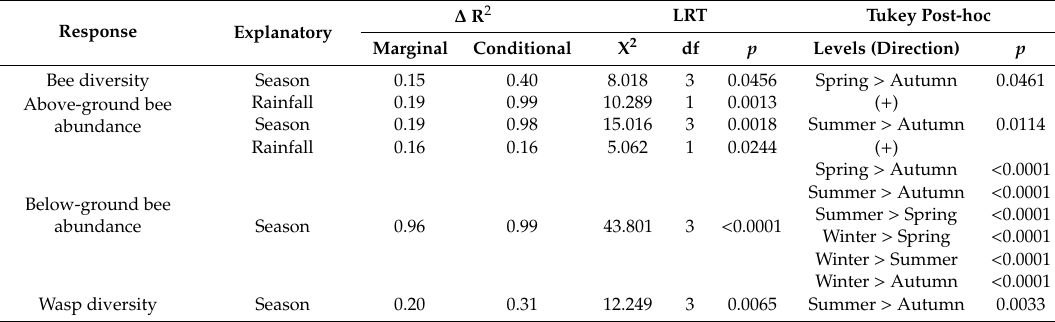
Table 5. Species richness, diversity, and abundance of bees and wasps in response to landscape simplification and season. Explanatory power of most parsimonious GLMMs including statistically significant variables is shown as variance of fixed (marginal R 2 ) and random e ff ects (conditional R 2 ). Significance levels of variables were assessed by likelihood-ratio tests (LRT) against null models (i.e., random factors only). Below-ground bee abundance is modelled as a presence-absence (binary) response. There was no significant model for bee richness, wasp richness, or wasp